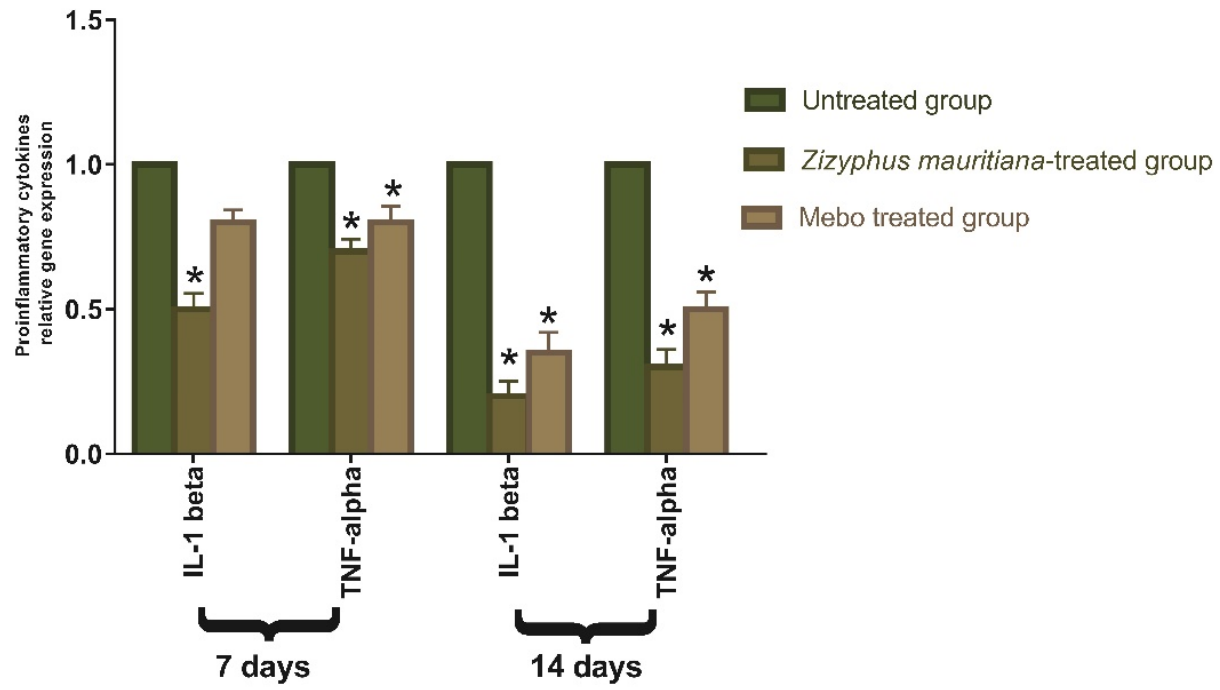
Figure 6. Quantitative RT-PCR analysis of genes expression in wound tissues of rabbits. Data represent fold change relative to the normal control group expression after normalization to glyceraldehyde 3-phosphate dehydrogenase (GAPDH). Bars represent mean ± SD. The significant difference between groups analyzed by a two-way ANOVA test, where: * p < 0.001 compared with those of the untreated group on the respective day.